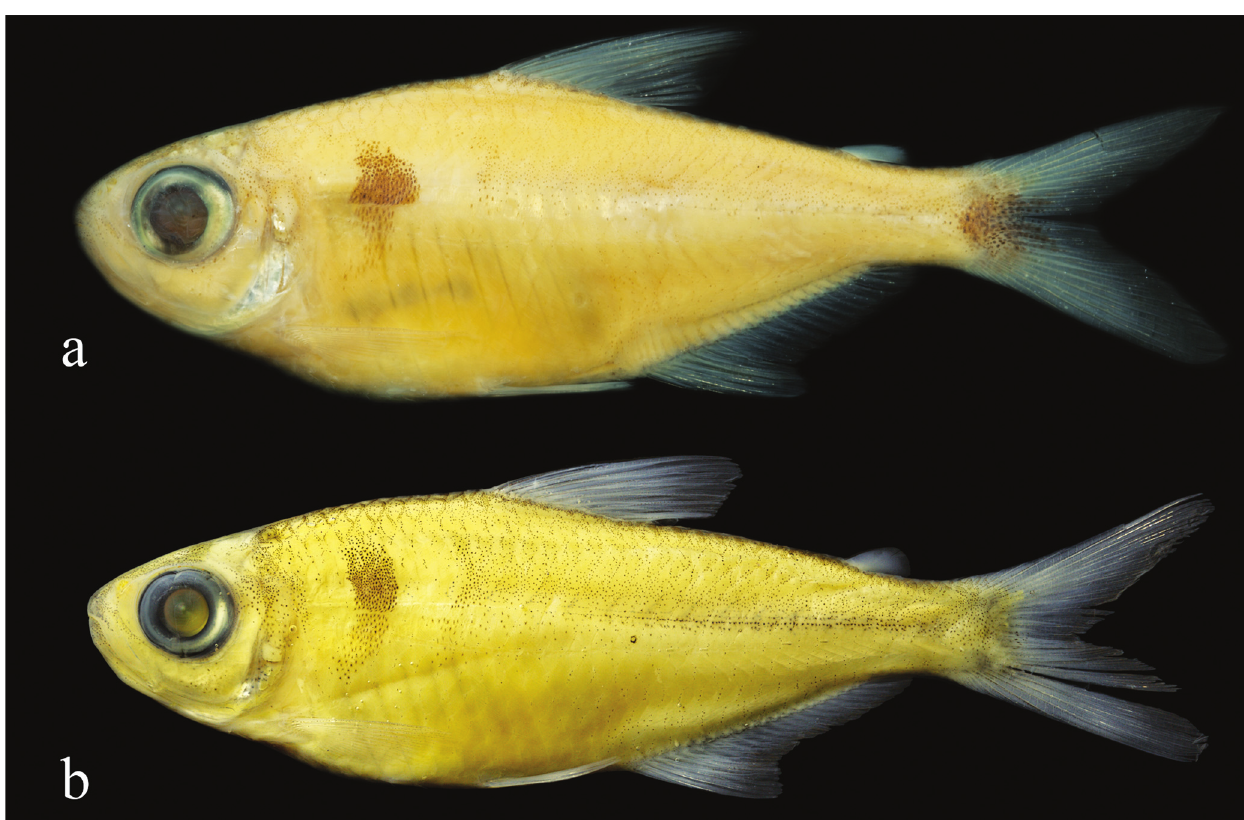
Fig. 6. ( a ) Jupiaba paranatinga , holotype, MZUSP 100855, 37.4 mm SL, rio Teles Pires, tributary of rio Tapajós, ( b ) Jupiaba cf. essequibensis , MZUSP 110952, 36.7 mm SL, rio Xingu; both collected in syntopy with Astyanax multidens